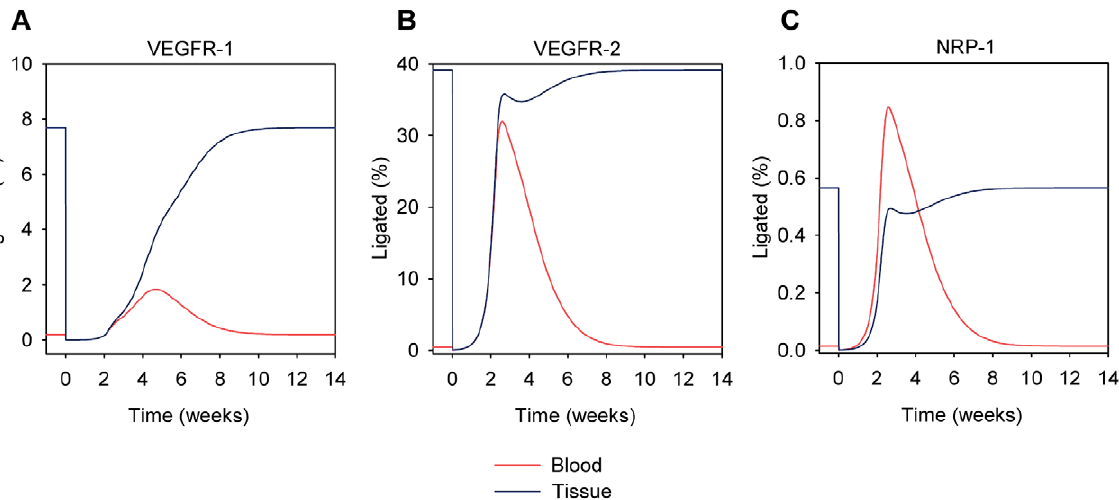
Figure 10. VEGF Receptor fractional occupancies upon injection of anti-VEGF (VEGF Trap). The fractional occupancies of (A) VEGFR-1, (B) VEGFR-2, and (C) NRP-1 are shown for the blood (red) and tissue (blue) compartments following a 25 mg/kg injection of the anti-VEGF agent into the blood compartment at 0 weeks. For all three receptors in the blood compartment, the percent of receptors ligated with VEGF decreases to essentially zero quickly after the injection of the anti-VEGF; however, the percent of ligated receptors then increases to values above pre-injection levels before returning to pre-injection levels. In the tissue compartment, this effect is not seen as the percent of ligated receptors decreases quickly after injection and then returns to pre-injection levels. Note that the y-axes of the panels are on different scales.